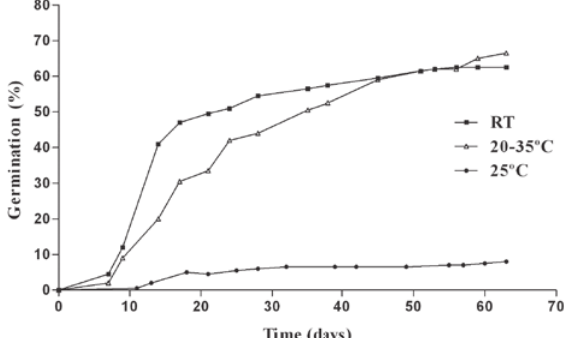
Figure 1 - Means of germination percentages of Melocactus violaceus at three different temperature treatments (alternating temperature between 20-35°C and room temperature (RT), and a constant temperature of 25°C) over 63 days.